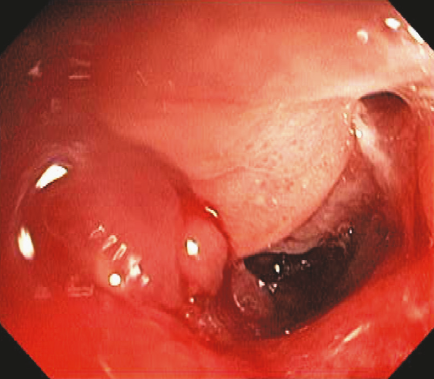
Figure 21: Endoscopic image of the ileocecal opening showing Crohn’s ileitis with a fistula opening at 2 o’clock in the right upper corner.